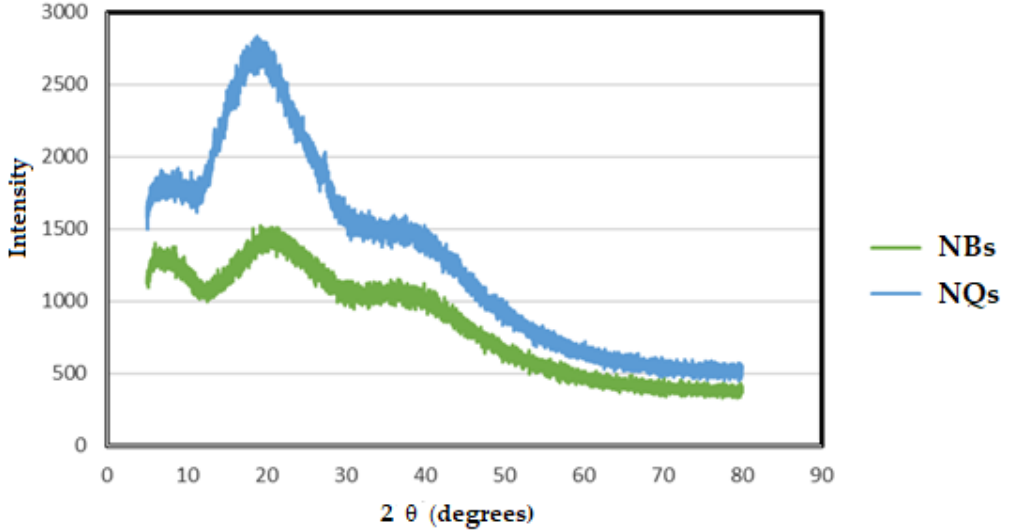
Figure 9. X-ray diffraction (XRD). Pattern of inulin non-charged nanoparticles (NBs) (green line) and inulin nanoparticles loaded with quercetin (NQs) (blue line).